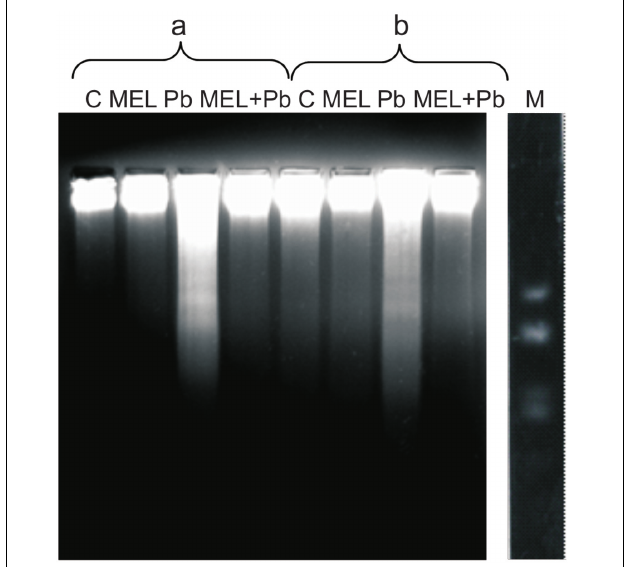
FIGURE 4 | Induction of DNA fragmentation in BY-2 cells exposed to lead. C, BY-2 cells cultured on LS medium – the control variant; MEL, BY-2 cells cultured on LS medium with 200 nM melatonin added from the beginning of the culture; Pb, BY-2 cells cultured on LS medium with 15 µ M Pb 2 + added on the 4th day of the culture and MEL + Pb, BY-2 cells cultured on LS medium with melatonin added from the start of the culture and with Pb 2 + added on the 4th day of culture. DNA was obtained from the cells: 4, on the 4th day – 4 h after lead administration and 6, on the 6th day – 2 days after